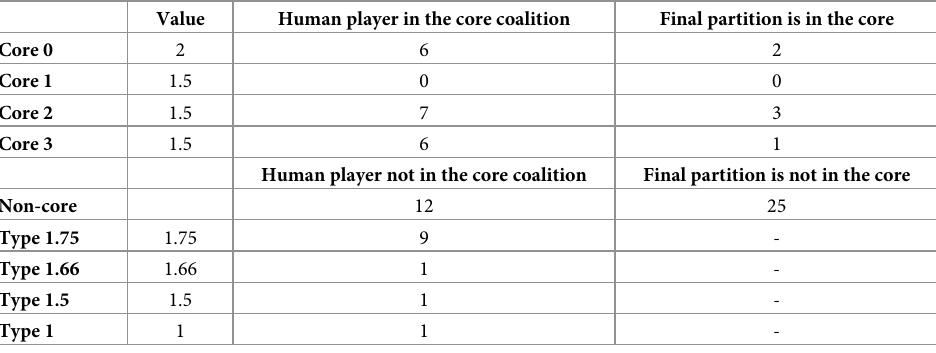
Table 7. Frequency of coalition structure